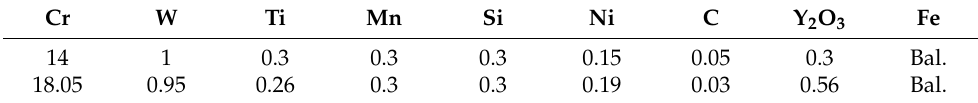
Table 1. Chemical compositions (wt%) of the studied materials: Fe-14Cr ODS and Fe-18Cr ODS. Cr W Ti Mn Si Ni C Y 2 O 3 Fe 1